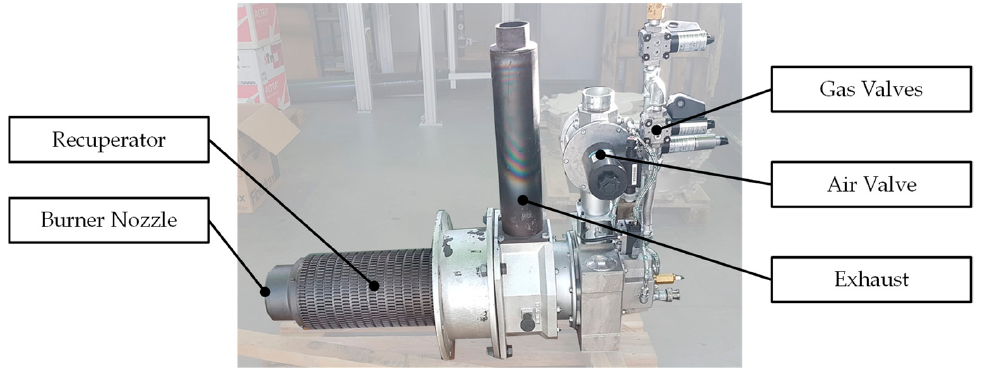
Figure 4. Rekumat ® M250 self-recuperative burner.